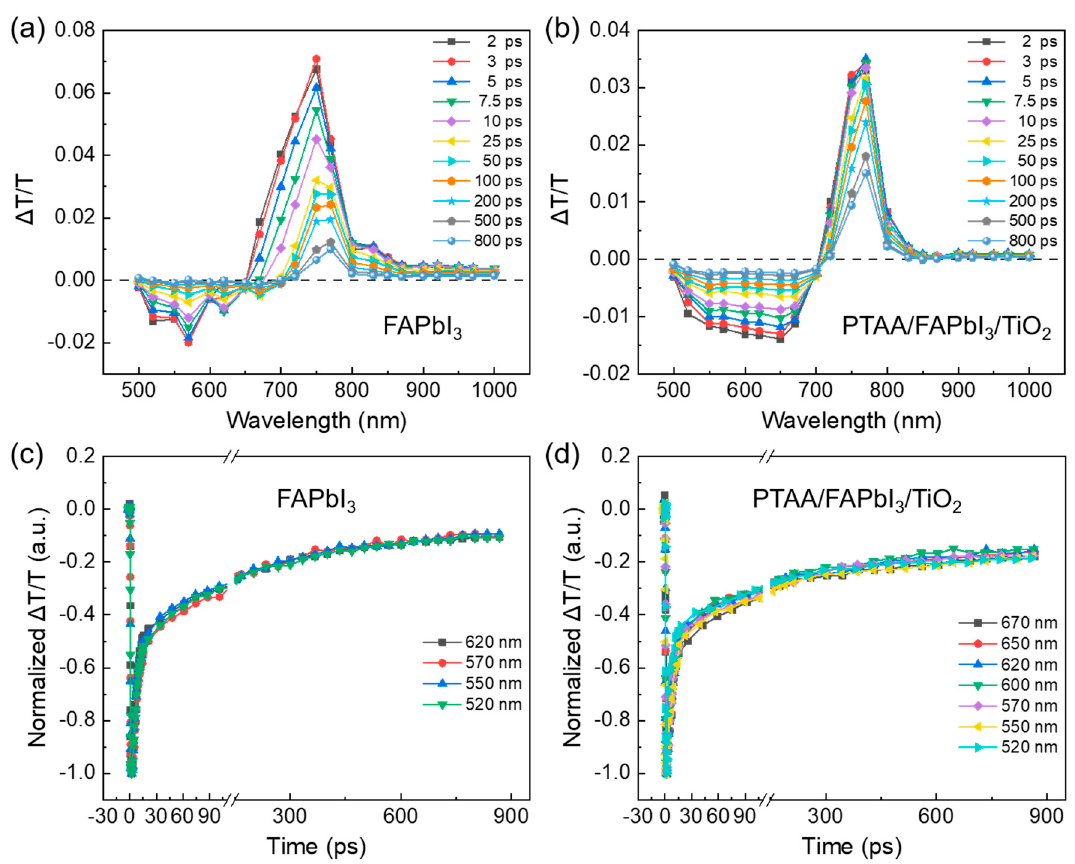
Figure 2. Differential transmission spectra of ( a ) pure FAPbI 3 PQDs film excited at 400 nm with pump fluence of ≈ 70 µJ/cm 2 and ( b ) PTAA HTL/FAPbI 3 PQDs/TiO 2 ETL excited at 400 nm with pump fluence of ≈ 21 µJ/cm 2 . The numbers marked in the upper right corner indicate the delay times between the pump and probe pulses. Transient Δ T / T traces of ( c ) pure FAPbI 3 PQDs film (400 nm pump 14 µJ/cm 2 ) and ( d ) PTAA HTL/FAPbI 3 PQDs/TiO 2 ETL (400 nm pump 21 µJ/cm 2 ) probed at different wavelengths.